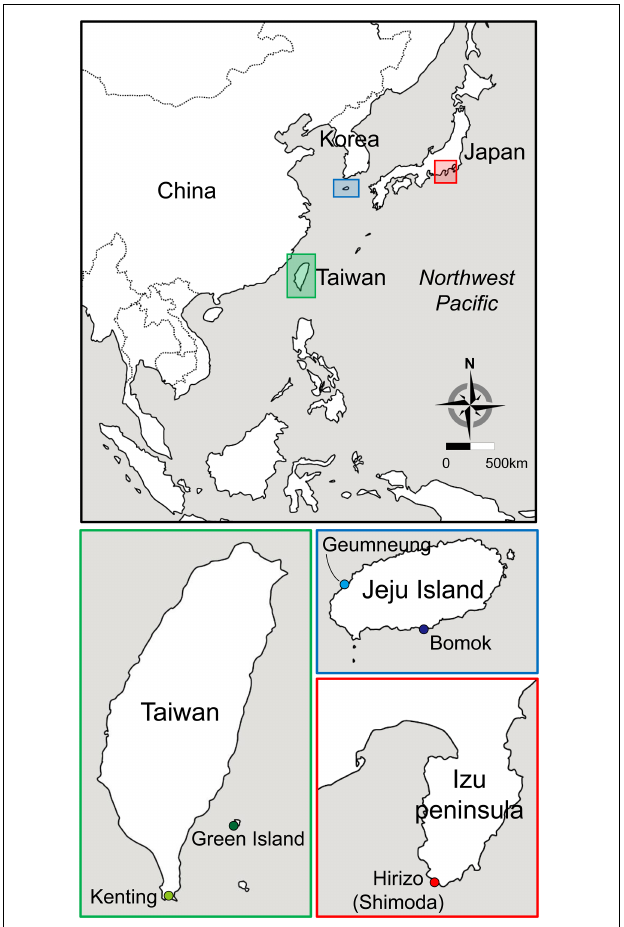
FIGURE 2 | Map of five sampling sites of A. japonica and its symbiont Symbiodiniaceae in the northwestern Pacific Ocean [Jeju Island: Bomok